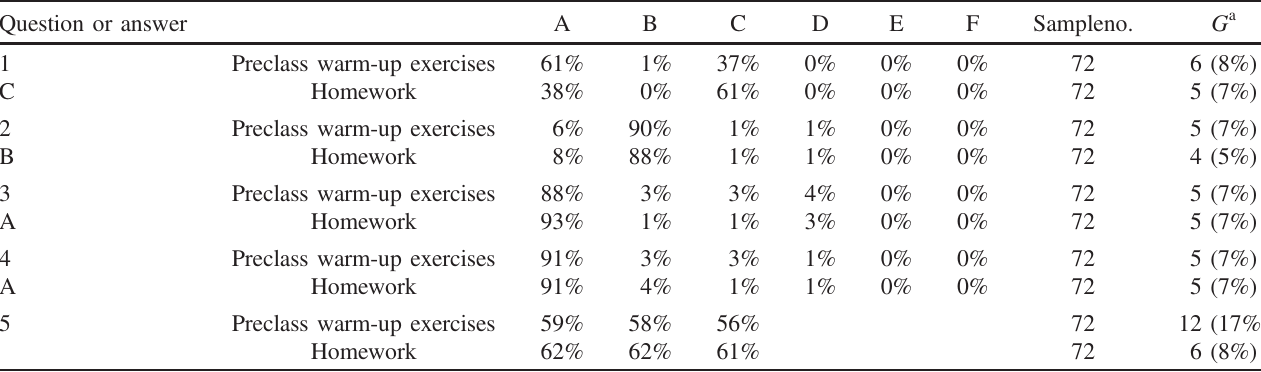
TABLE VI. Student responses to the online warm-up exercises and